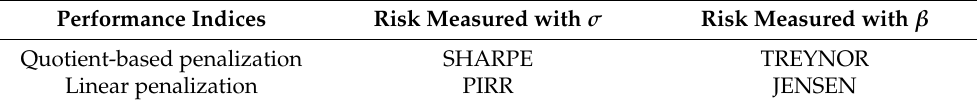
Table 4. Performance Indices. Performance Indices Risk Measured with σ Quotient-based penalization